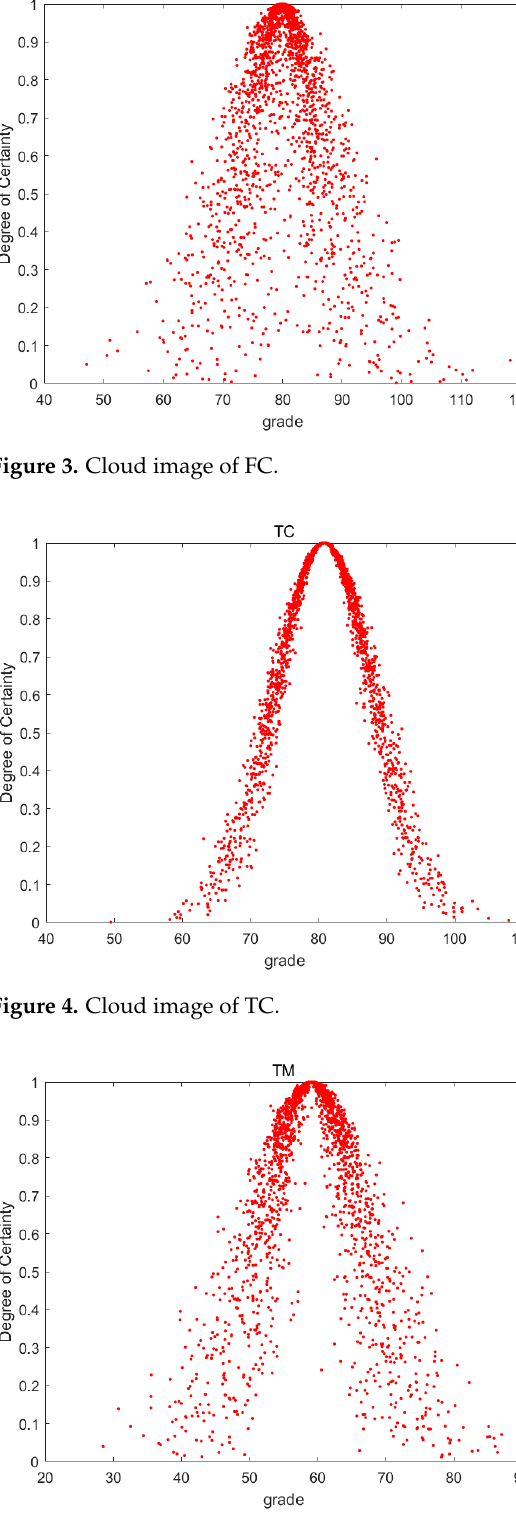
Figure 6. Cloud image of LG. Figure 7. Cloud image of RW. Figure 8. Cloud image of RN.